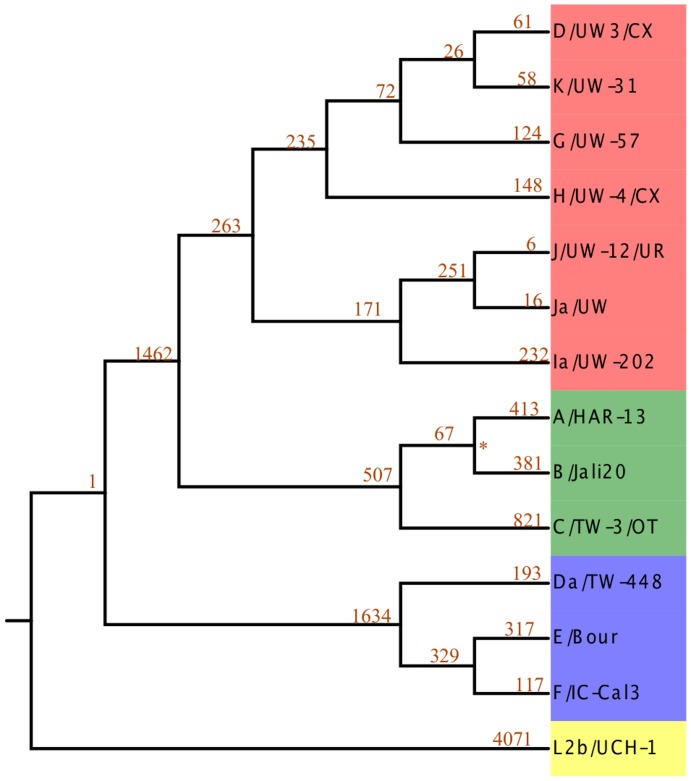
Whole-genome phylogeny of the reference C. trachomatis strains used in this study.The tree was constructed using a neighbor-joining algorithm based on whole-genome alignment. All the branches were supported by 100% confidence in 100 bootstrap sampling except for the A/HAR-13/B/Jali20 branch. All nodes with bootstrap support <100% are designated with an asterisk. Each leaf and internal branch has the number of SNPs unique to this branch compared to the CT-ASR, reconstructed ancestral sequence. The leaves are colored by membership of major C. trachomatis Clades [7]: yellow, blue, green and red for Clades 1–4, respectively.